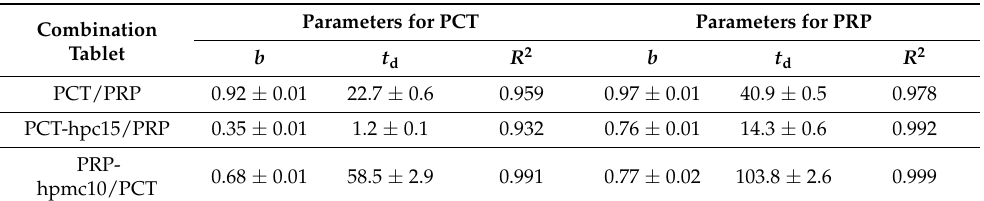
Table 9. Weibull equation parameters (mean ± SD, n = 3) for the dissolution of paracetamol and propyphenazone form the optimized formulations and the physical